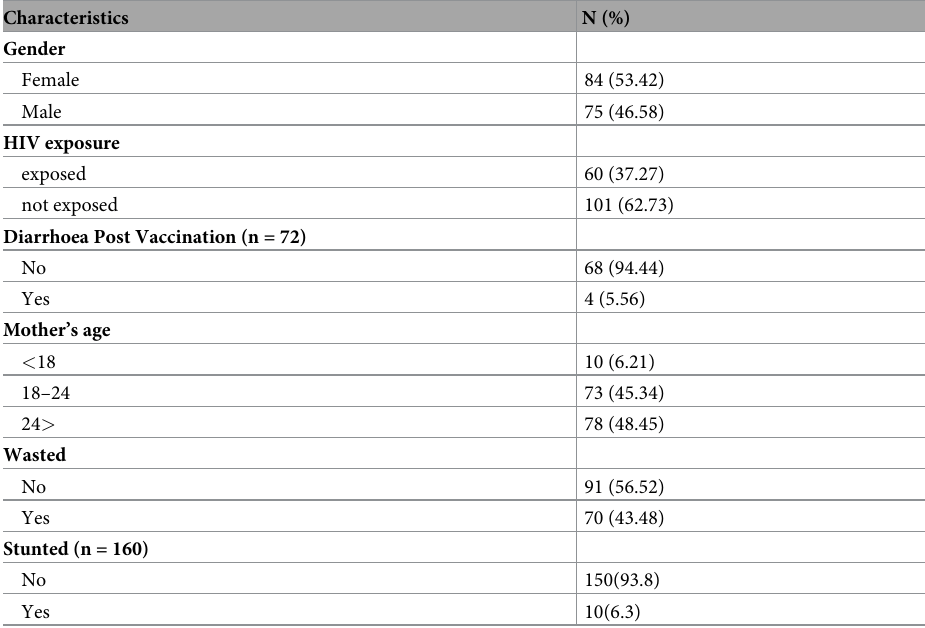
Table 1. Characteristics of the study